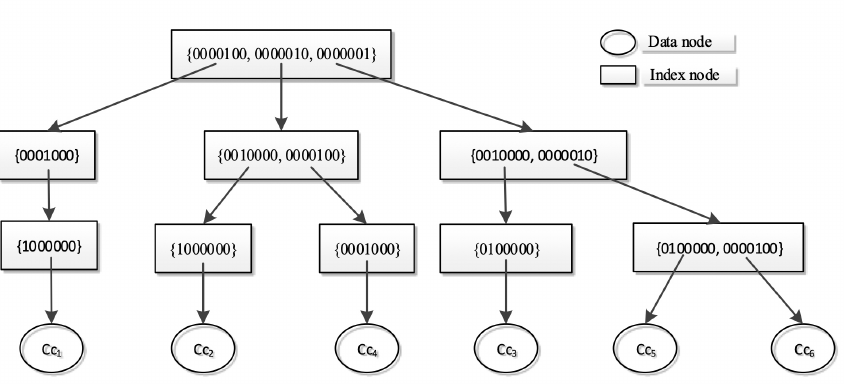
Figure 7. Index structure of cycles in G 2